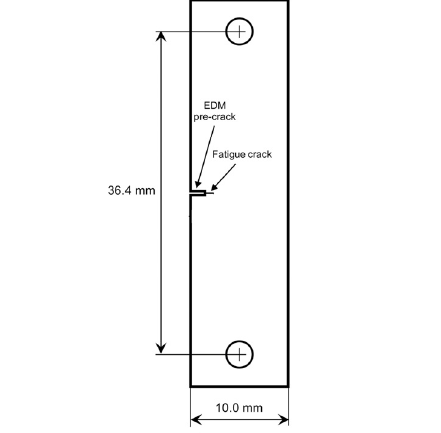
Figure 1: Loading-unloading isothermal stress-strain cycle (298 K) Figure 2: Single Edge crack